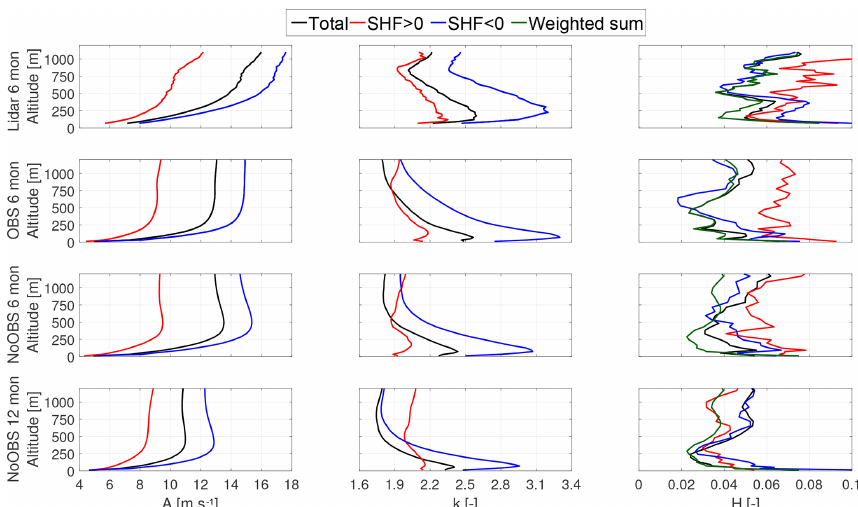
Figure 8. Weibull parameter trends over altitude and goodness of fit quantified by the Hellinger distance (right) over altitude for 6 months of lidar measurements (first row panels), the 6-month OBS model (second row panels), 6-month NoOBS model (third row panels) and the 12-month NoOBS model (fourth row